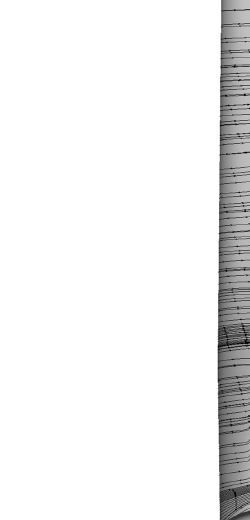
curves show a lead with respect to the flap signal. A more de- tailed elaboration of the torsion moment relative to the quar- ter chord point is also performed in Sect. 4.4.